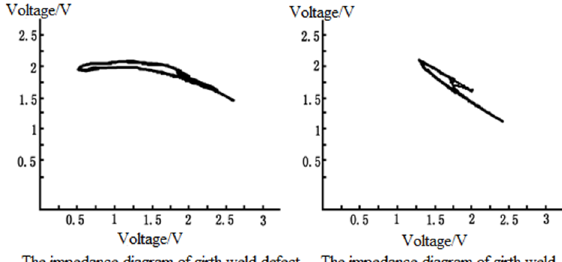
Figure 6. Impedance diagram of typical defective and non-defective girth welds.